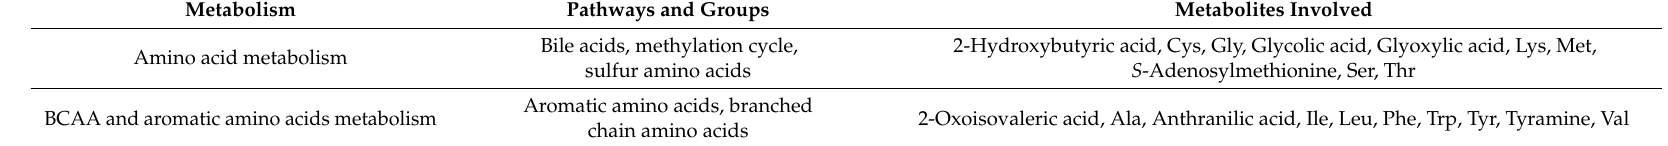
Table 1. Primary metabolic pathways occurring in M. incognita with their constituting groups of